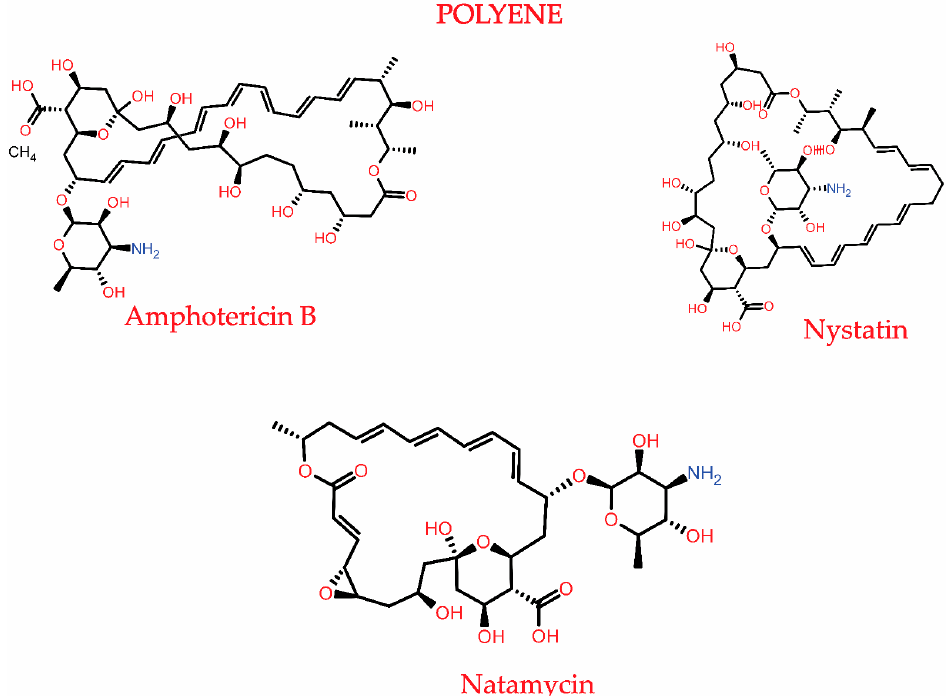
Figure 3. Two-dimensional structural formula for the most common drugs under the polyene anti- fungal group. All the 2D structures were plotted using the academic version of Maestro Schrödinger suite 2022 (Schrödinger Release 2022-3: Maestro, Schrödinger, LLC, New York, NY, 2021).